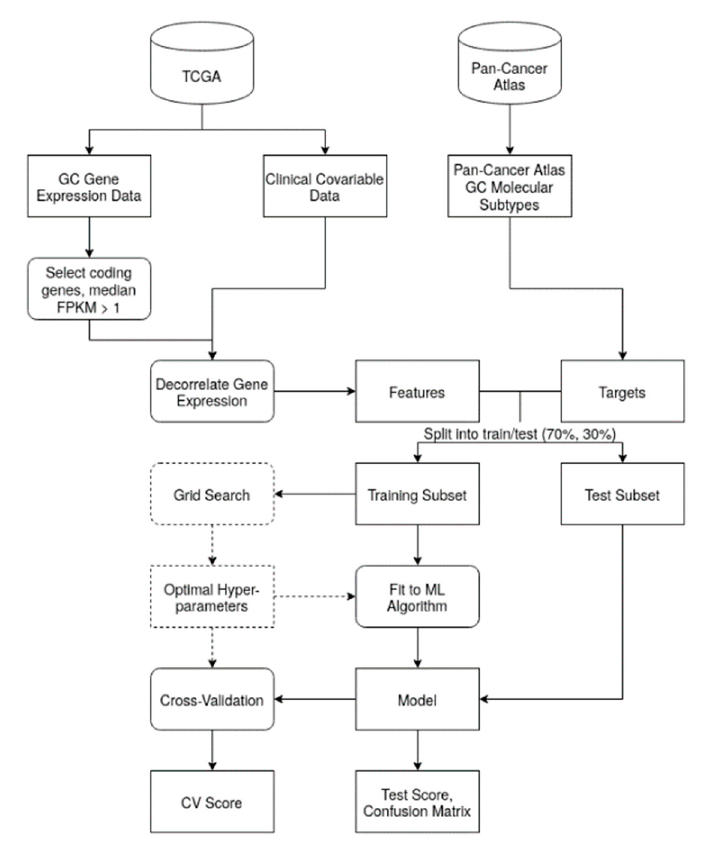
Figure 1. Diagram of the pipelines used in this work. Steps with a dashed line were only performed on pipelines with hyper-parameter